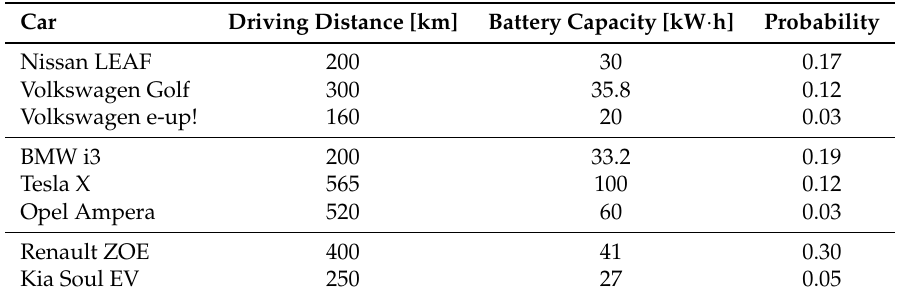
Table 2. Electric vehicles used in this experiment with approximated probabilities according to their selling distribution in Europe during 2017 [37].